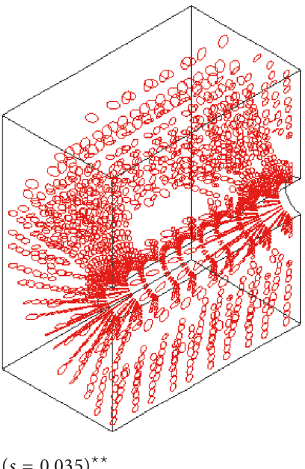
Figure 12: Displacement resulting from corrosion-induced expan- sion = 0.035 mm.